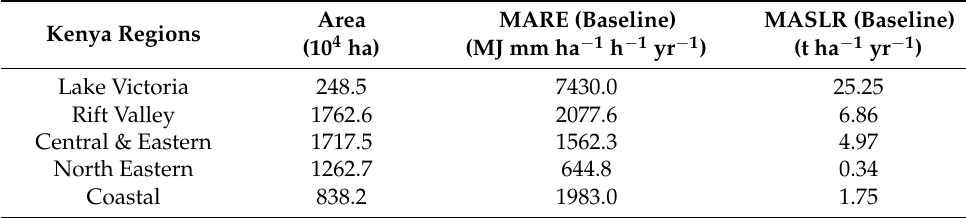
Table 8. Baseline soil erosion rates in Kenya regions.